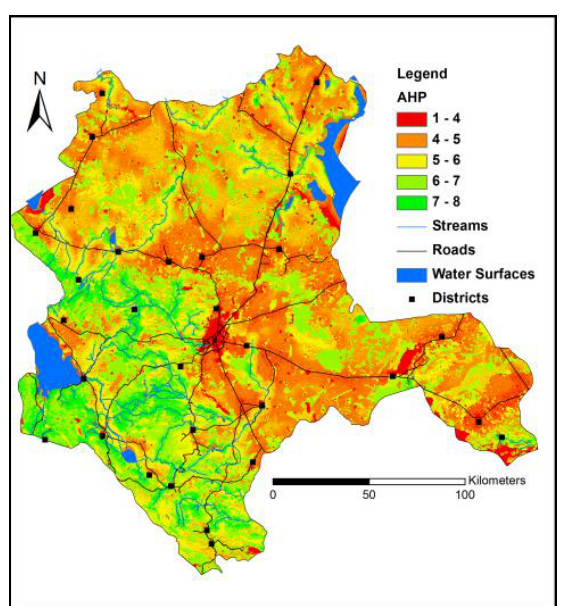
Figure 3. Suitability map